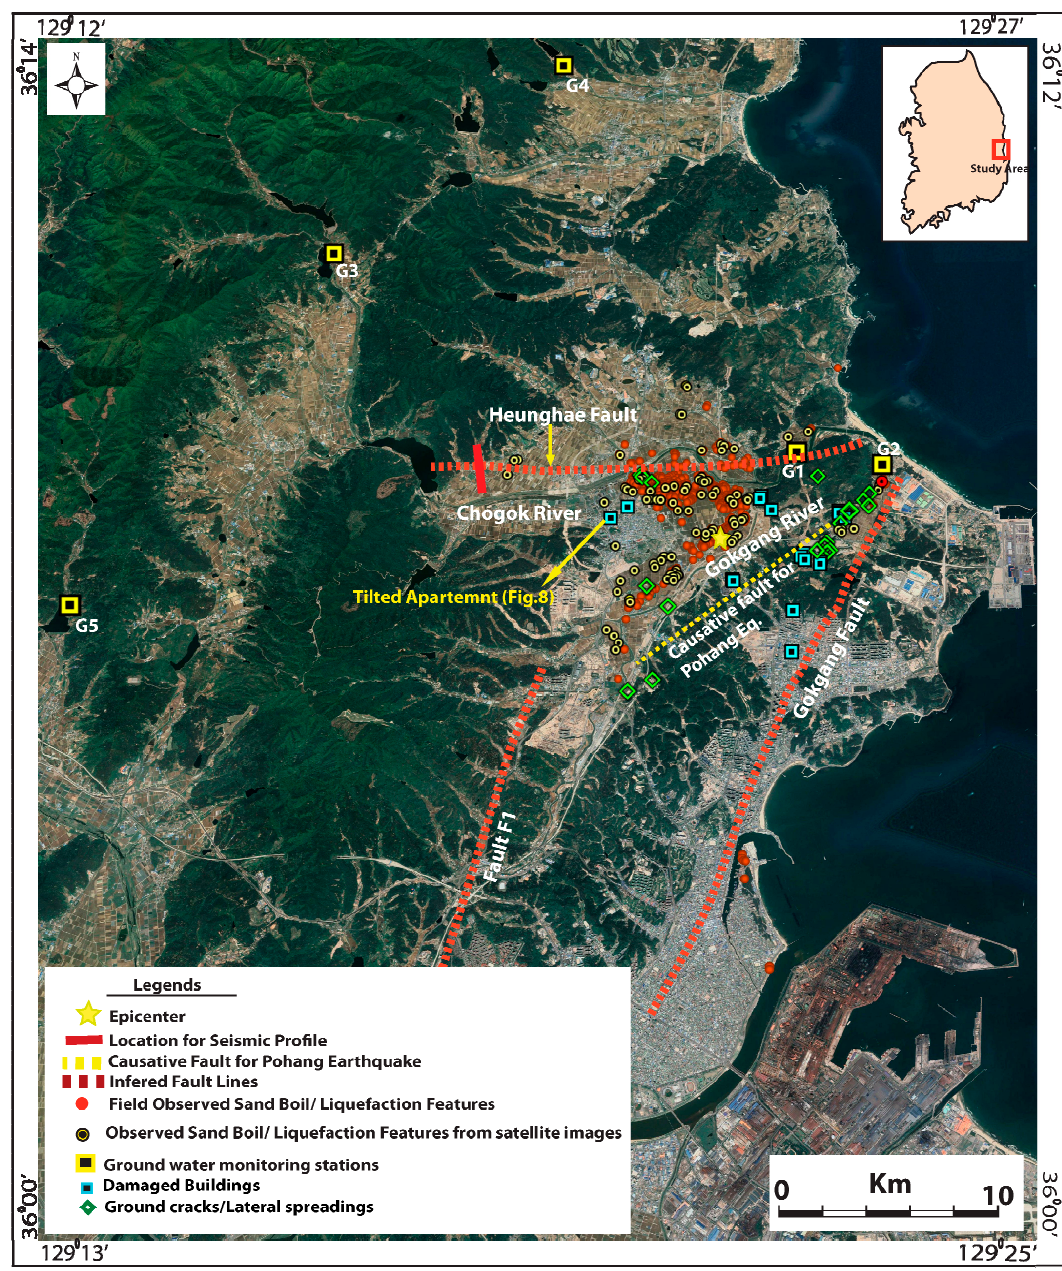
Figure 3. Google Earth image showing the major faults around the study area with the collected liquefaction features during the M W 5.4 Pohang earthquake. Most of the liquefaction features were clustered in the southern part of the Heunghae Basin and to the south of the Heunghae Fault (Sand boil data sets used in this diagram were collected ourselves and also taken from [40]). The red line indicates the location of geophysical profile taken across the Heunghae Fault.